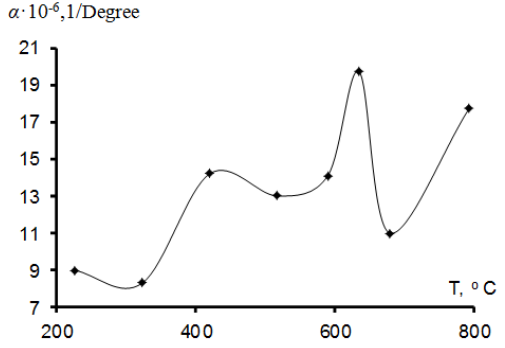
Figure 1. Thermal linear expansion of the α crystal lattices (steel 12H1MF).